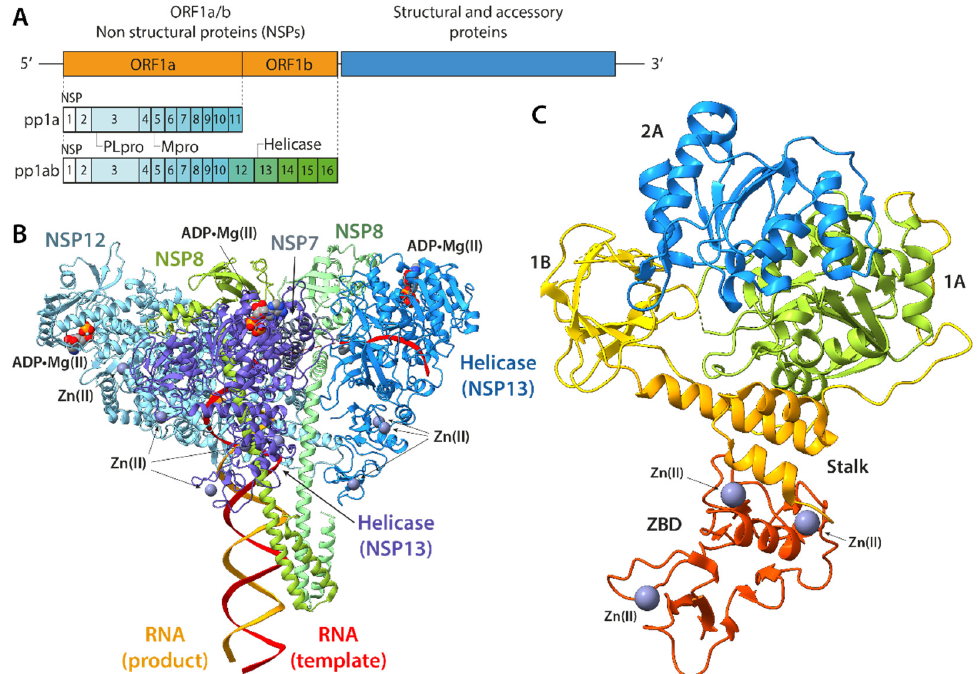
Figure 1. ( A ) Organization of the SARS-CoV-2 genome. The RNA encodes two categories of proteins: non-structural proteins (NSPs) and structural and accessory proteins. NSPs are encoded in ORF1a and ORF1b. Cap-dependent translation begins at ORF1a and produces pp1a, which encompasses NSP1–11, or pp1ab, which encompasses NSP12–16. ( B ) Ribbon diagram of the RdRp-(NSP13) 2 supercomplex structure in the RNA-engaged form (PDB ID: 7RDY). The NSP12 (RdRp), NSP7, and NSP8 subunits are in light blue, gray, and green, respectively. The two NSP13 subunits are in blue and violet for the RNA-engaged and the RNA-free form, respectively. The template and the product RNA strands are in red and orange, respectively. Zn(II) and Mg(II) ions, as well as ADP molecules are reported as spheres colored according to the atom type. ( C ) Ribbon diagram of NSP13 in the RNA-free form (PDB ID: 6ZSL). The ribbons are colored in red, orange, yellow, green, and blue to highlight the position of the ZBD, Stalk, 1B, and 1A and 2A domains, respectively. Zn(II) ions are reported as purple spheres.